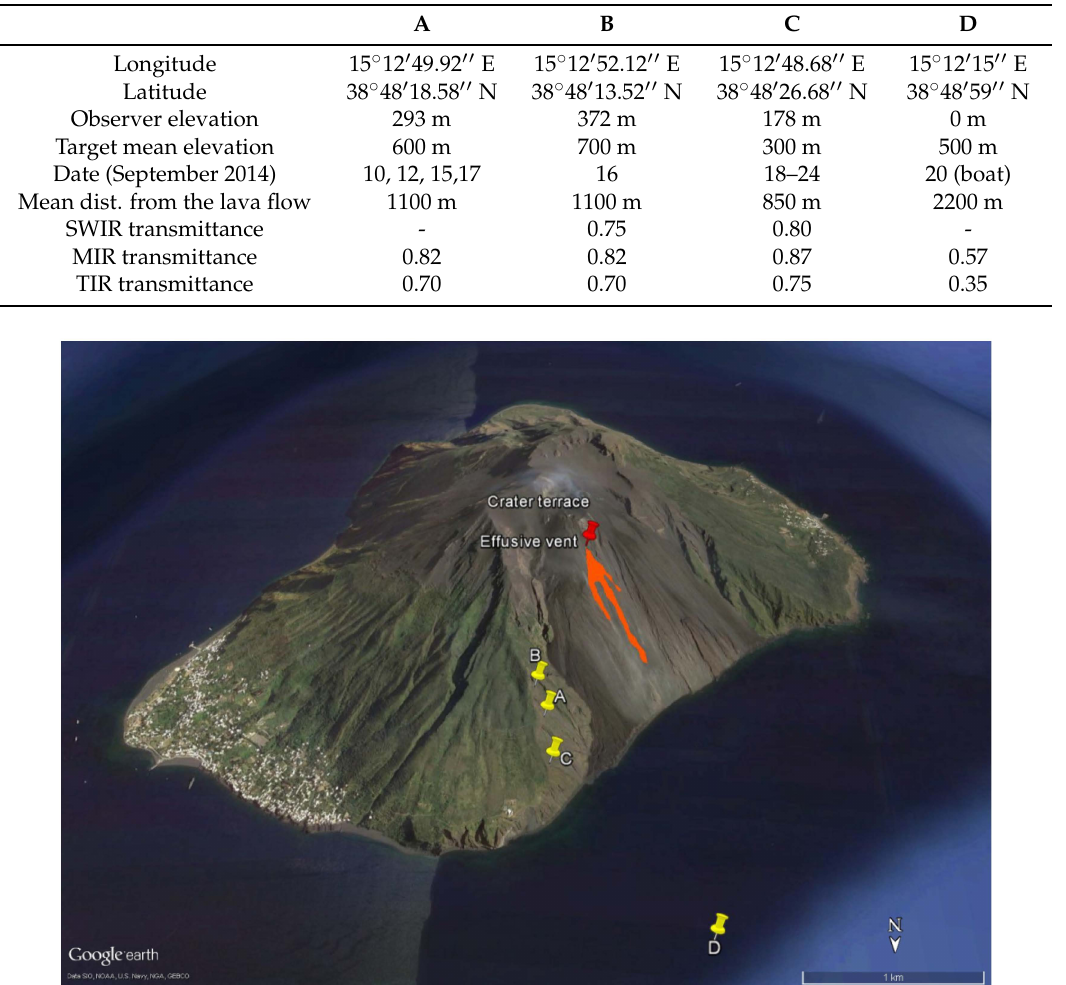
Table 2. Field observation metadata; point D corresponds to the observations conducted from the boat.